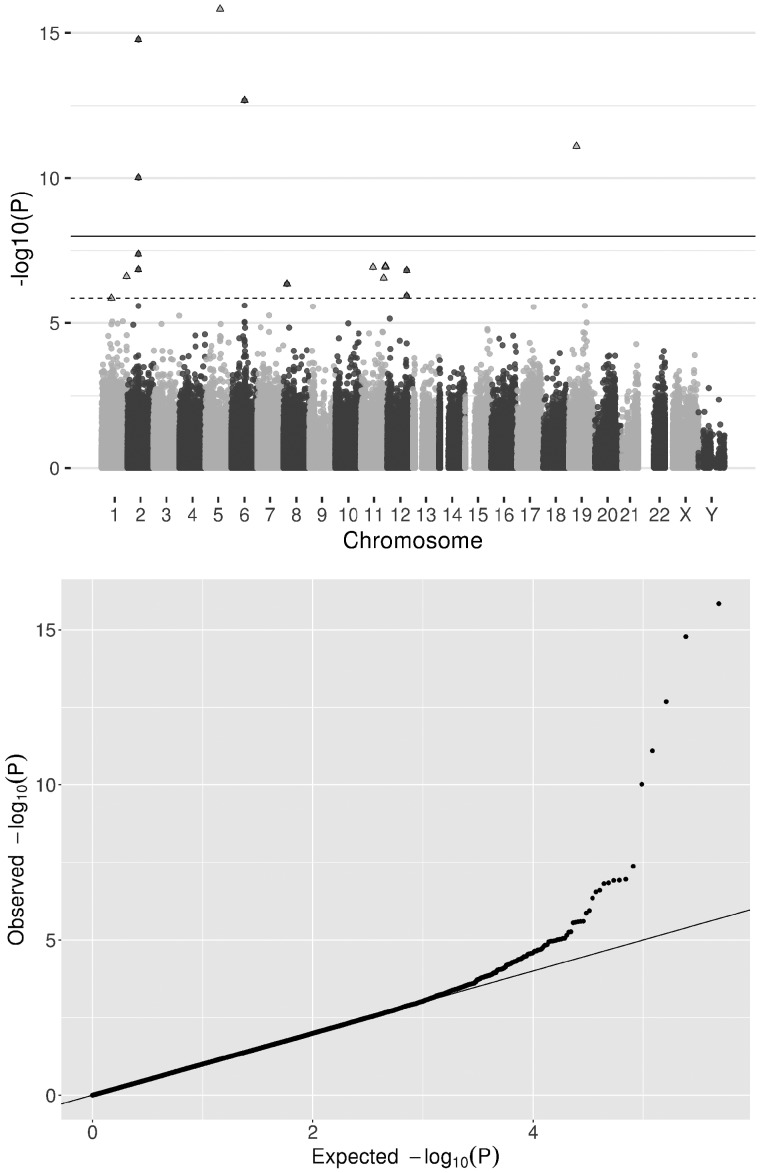
Observational associations of DNA methylation and lung cancer: a fixed effects meta-analysis of lung cancer EWAS weighted on the inverse variance was performed to establish the observational association between differential DNA methylation and lung cancer. a) Manhattan plot, all points above the solid line are at P < 1 x 10-7 and all points above the dashed line (and triangular points) are at FDR <0.05. In total, 16 CpG sites are associated with lung cancer (FDR <0.05). b) Quantile-quantile plot of the EWAS results [same data as (a) Manhattan plot].